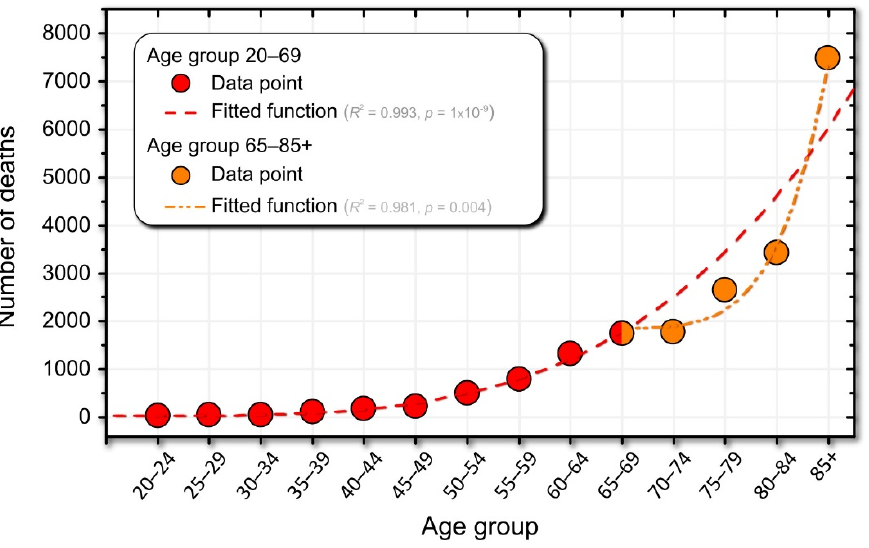
Figure 5. The number of deaths in Slovenia (data from the Statistical Office of the Republic of Slovenia) . The dashed red line represents the power-law fit of the data. The dash-dotted orange curve represents the power-law fit for the population over 70 years of age). The legend contains information on the best-fit functions.